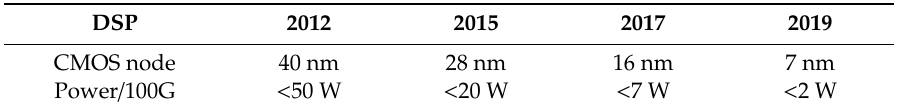
Table 2. 400G-ZR QSFP-DD power consumption. TROSA: transmitter and receiver optical subassembly, QSFP-DD: quad small form factor double density. Module